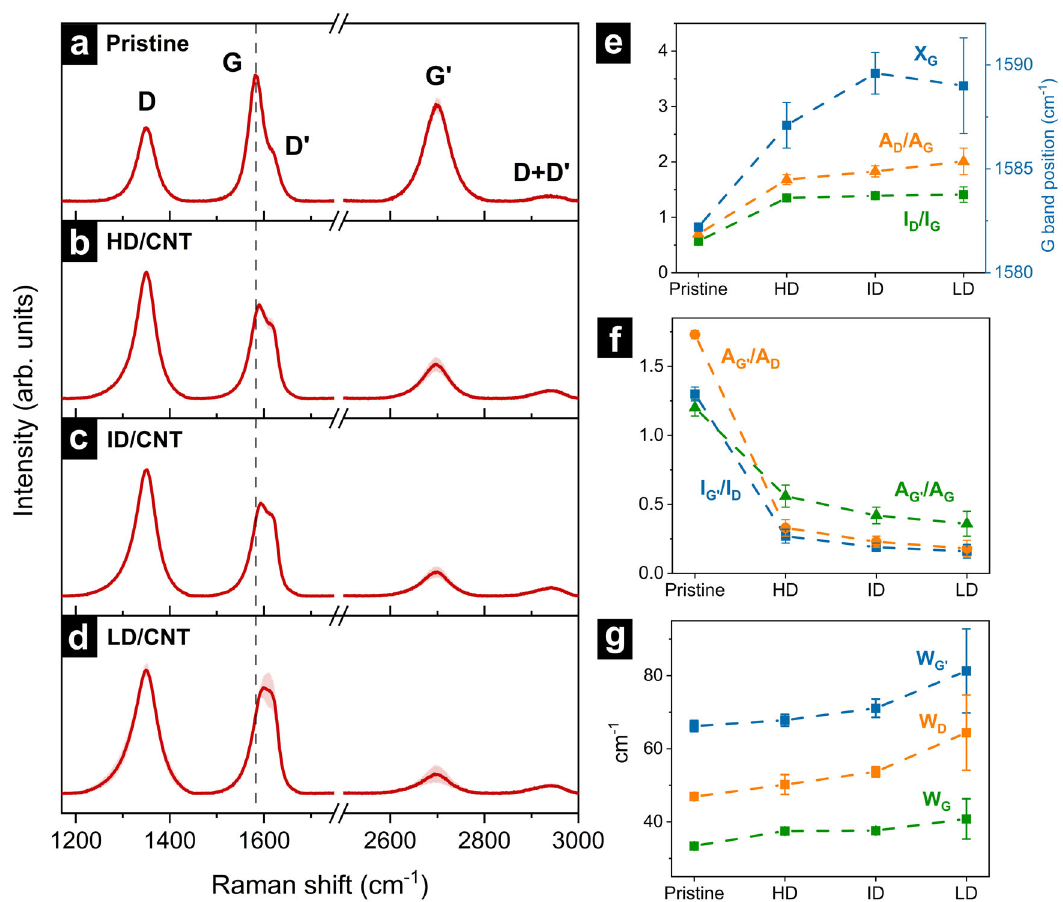
Fig. 3 Raman spectra and indicator developments of CNTs in pristine condition and after tribological testing. Raman spectra of a pristine CNTs and CNTs after tribological testing on b HD, c ID, and d LD surfaces, including standard deviation of spectral intensities (red area). Development of e I D /I G , A D /A G , X G f I G ’ /I D , A G ’ /A D , A G ’ /A G and g W D , W G , W G ’ with increasing structural depth (error bars represent standard deviation from three independent measurements).